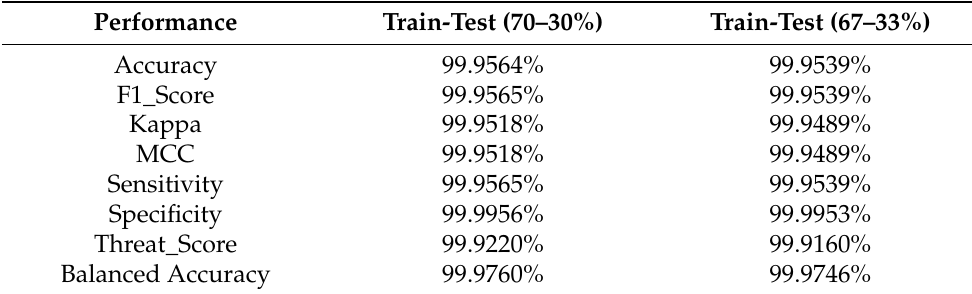
Table 4. Performance Evaluation on Different Train-Test